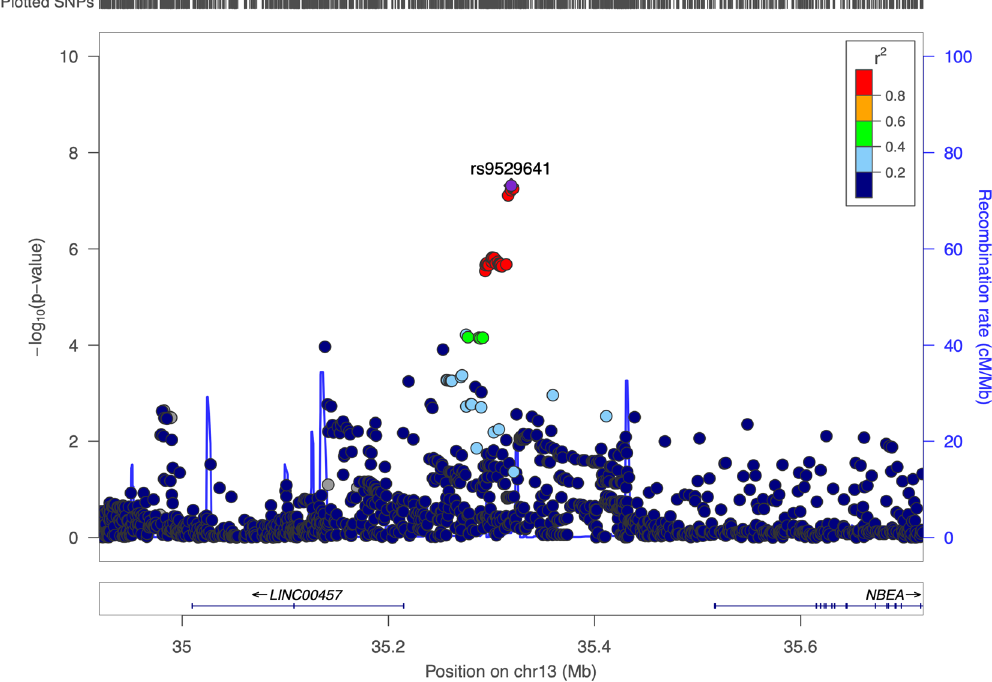
Figure 1. Locus Zoom plot of the SNP rs952964 (± 200 kb) on chromosome 13 [position: 35,319,175, minor allele frequency: 0.25, beta: 0.12 (0.02)] showing genome-wide significant association with science attainment during adolescence (11–14 years). The y-axis shows the p-value and the x-axis shows position on chromosome 13. Points show other SNPs located in this region—the purple SNP is the lead SNP and the other colours show the level of LD shared with the lead SNP.